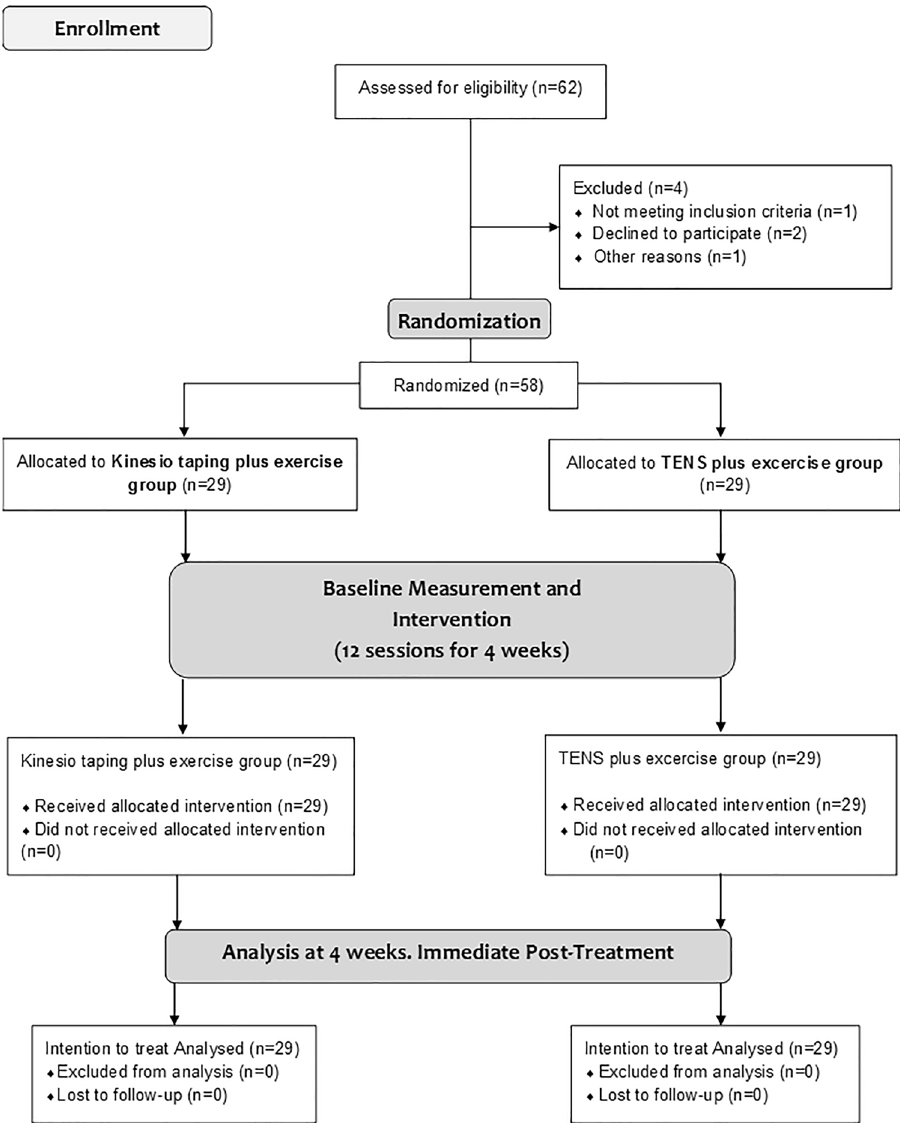
Figure 3. Flow diagram of the recruitment and follow-up of patients throughout the